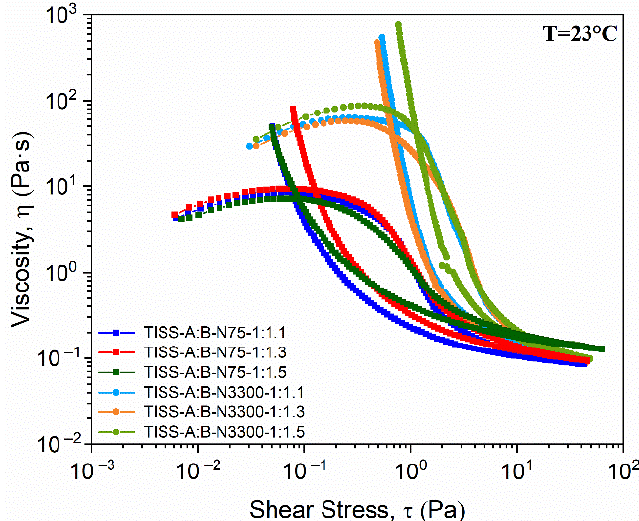
Figure 8. Flow curves of TISS paint coatings, prepared with the binder L200 and various concentra- tions of two catalysts Desmodur N75 and Desmodur N3300, respectively.